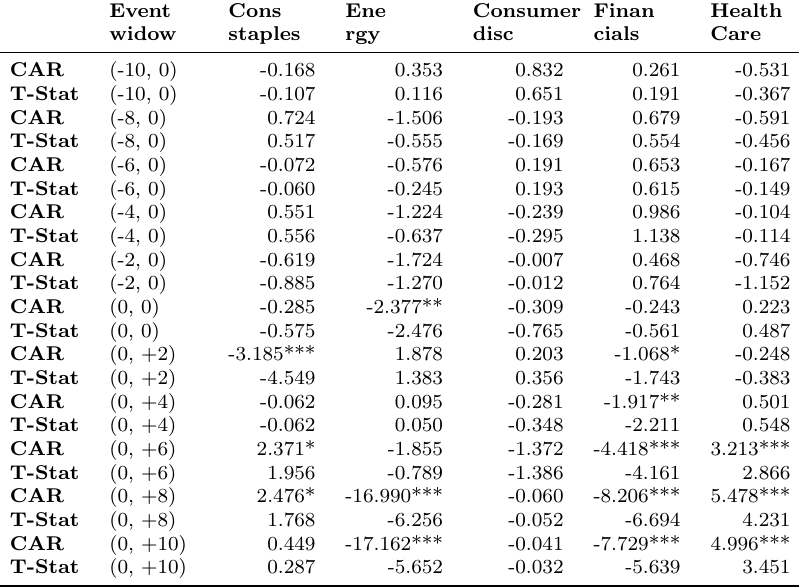
Table 3: Event 2: 26-02-2020 First Local Transmission Case Event